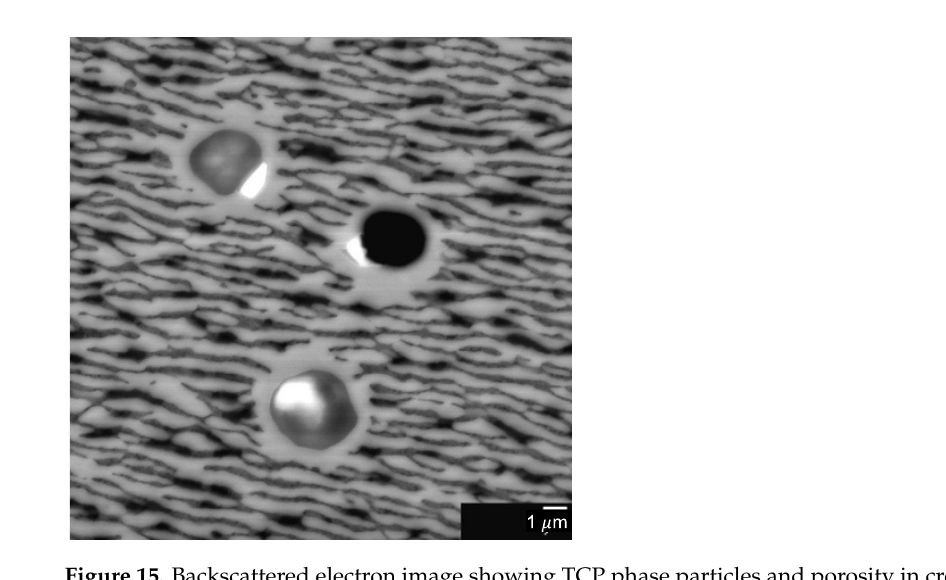
Figure 15. Backscattered electron image showing TCP phase particles and porosity in crept HIPed material [51].